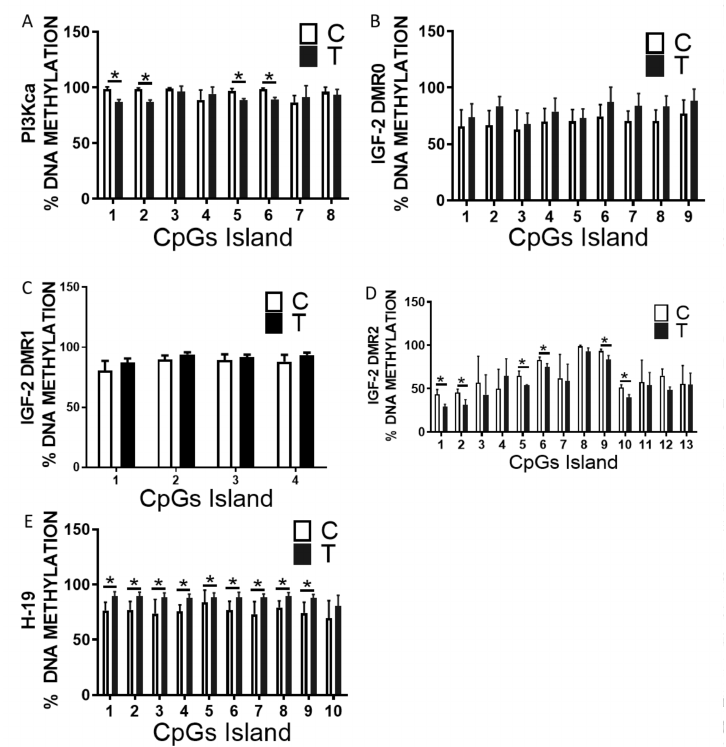
Figure 5. DNA methylation analysis of progenitor sperm from sedentary or exercise-trained males. DNA methylation percentage at the ( A ) PI3Kca intragenic region, ( B ) Igf2 DMR-0, ( C ) Igf2 DMR-1, ( D ) Igf2 DMR-2, and ( E ) H19 DMR in sperm of exercise-trained TF 0 male (black bars) or